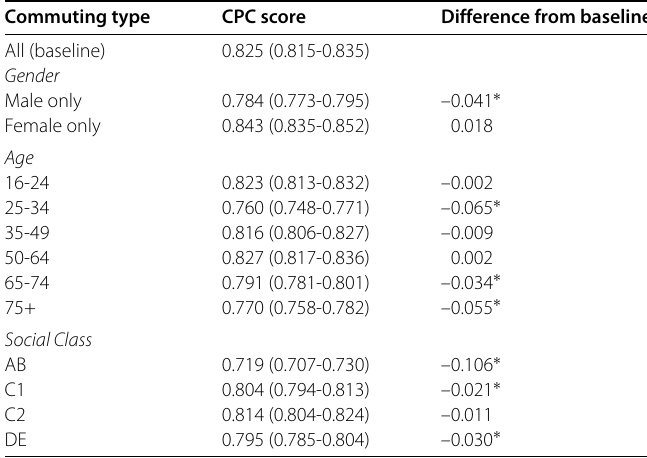
Table 2 CPC scores for the estimated Twitter commuting matrix ( λ = 0.90) compared against census commuting volumes divided by gender, age and social class. Internal commuting is included. Brackets contain bootstrapped 95% confidence intervals. * indicates the confidence interval for the category being considered does not overlap with the interval for the full census CPC